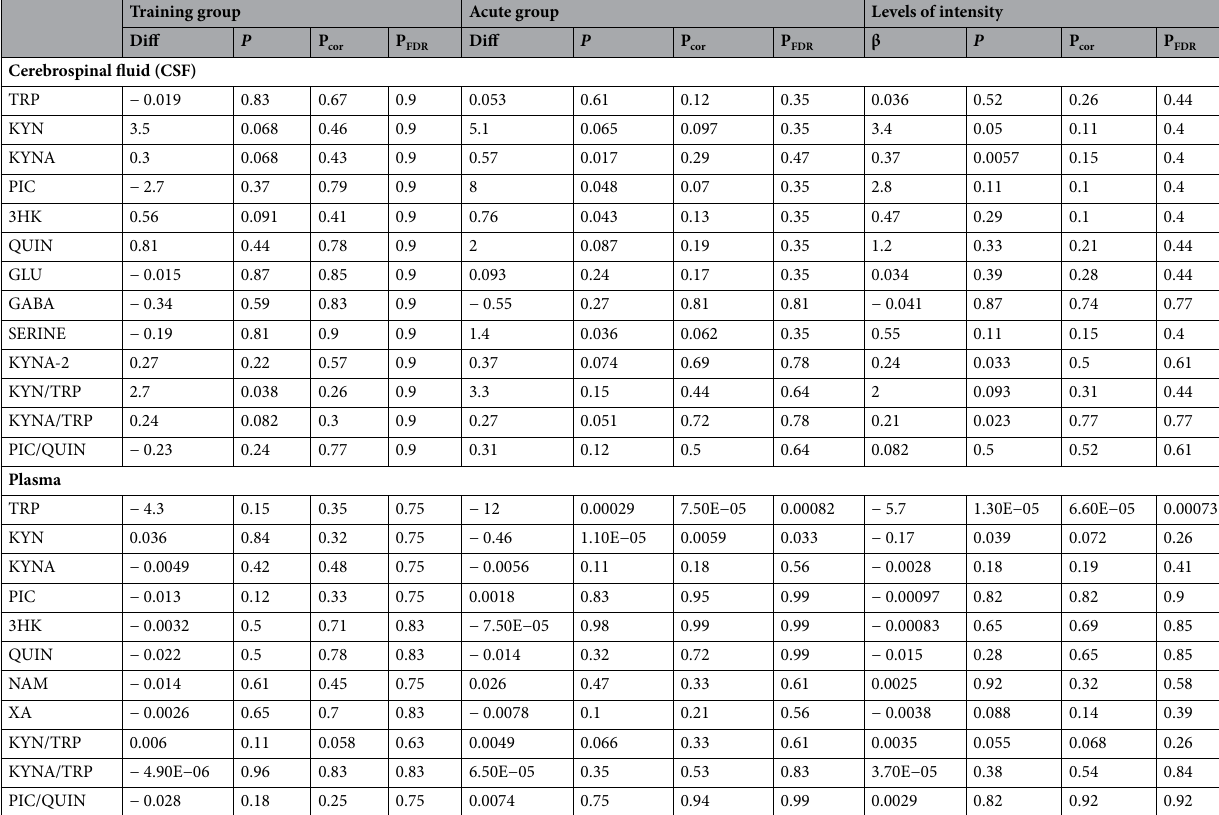
Table 4. Effects of aerobic exercise on tryptophan and kynurenine pathway metabolite levels in cerebrospinal fluid and plasma. Summary statistics of paired Student t-tests comparing before-and-after